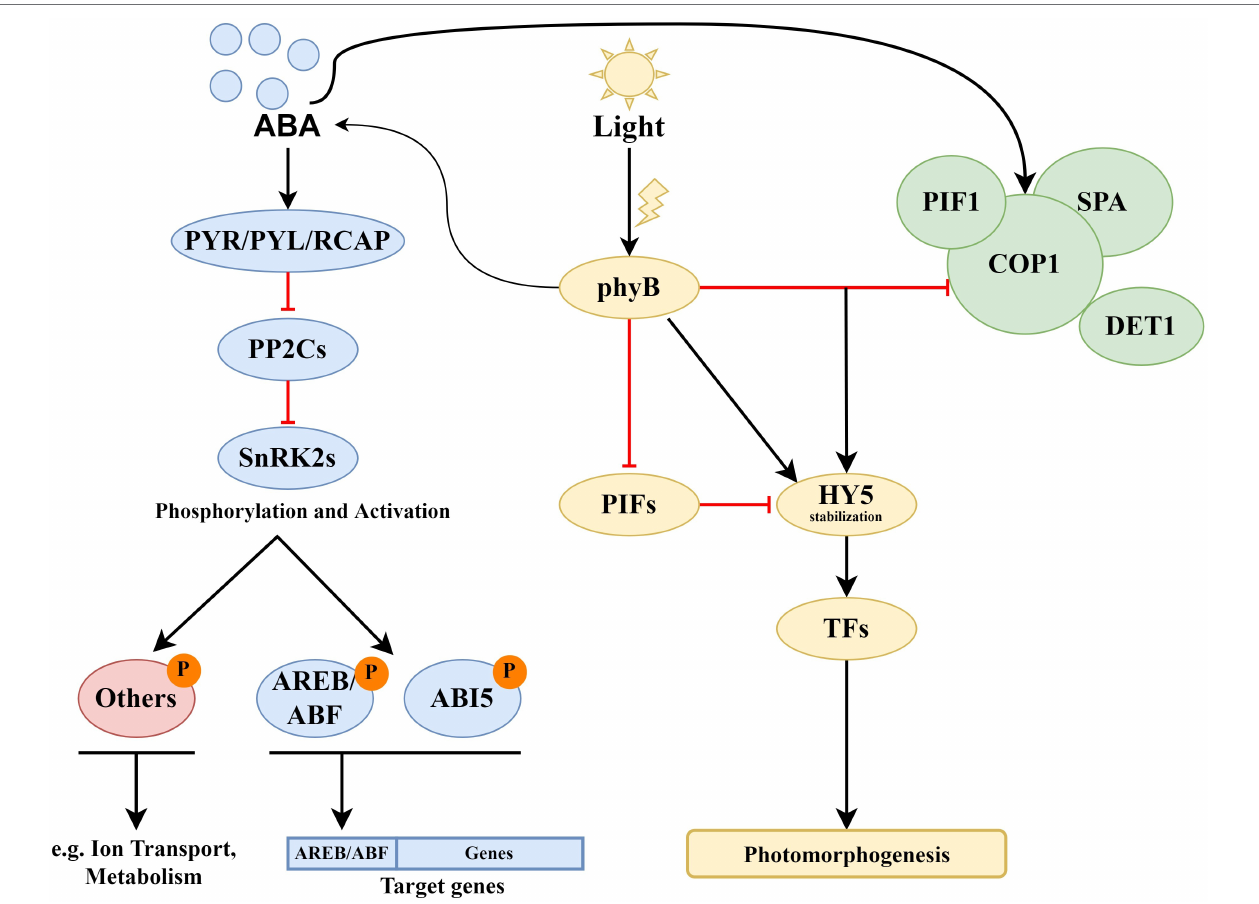
FIGURE 1 | Core components of the ABA and light signaling systems. Long-term ABA treatment causes COP1 activation and phyB stimulates the ABA biosynthesis. ABA activates ABA receptors of the PYR/PYL/RCAR family that inhibits A-type protein phosphatases 2C (PP2Cs). PP2C inactivation activates class 3 sucrose nonfermenting-1- related protein kinases (SnRK2s) that phosphorylate ABA-responsive element binding factors AREB/ABF. Activated ABFs initiate the expression of responsive genes by binding to the cis -acting ABA response element (ABRE). In response to light, phytochromes inactivate COP1-SPA complexes and induce degradation of negative regulators of photomorphogenesis, PIFs. PhyB inhibits the regulatory activity of PIF1 and PIF3. These events promote photomorphogenesis by establishing the dynamic protein module PIF1-COP1/SPA1 and triggering HY5-mediated light signaling. Degradation of PIFs and stabilization of HY5 result in promotion of photomorphogenesis. HY5 physically interacts with transcription factors (TFs) and other proteins, and directly affects the expression of numerous genes. By promoting COP1 protein destabilization and turnover, DET1 positively regulates COP1 activity toward the degradation of HY5. Keeping HY5 levels tightly regulated is essential for its functioning during dark-to-light